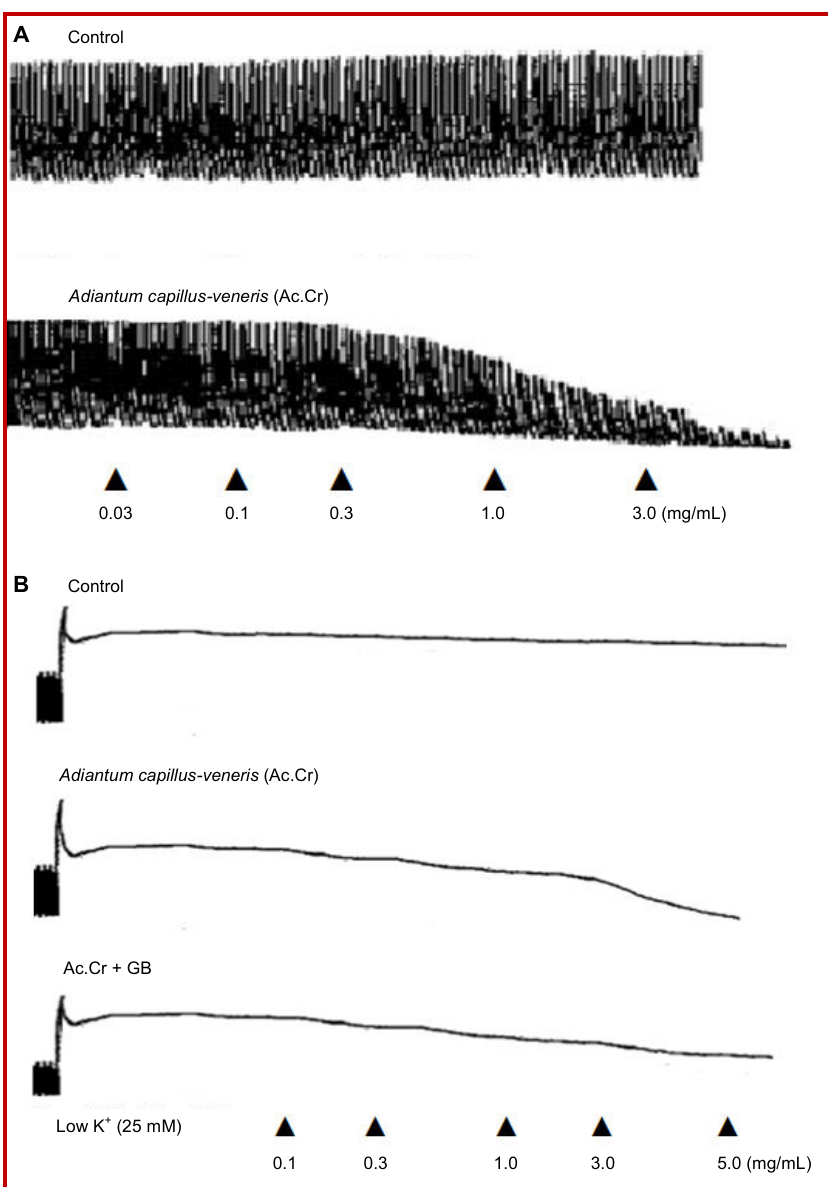
Figure 1: Tracing showing the concentration-dependent inhibitory effect of the crude extract of A. capillus-veneris (Ac.Cr) on (A) spontaneous and (B) low K + (25 mM)-induced contractions without and with glibenclamide (GB, 10 µM) in isolated rabbit jeju- num